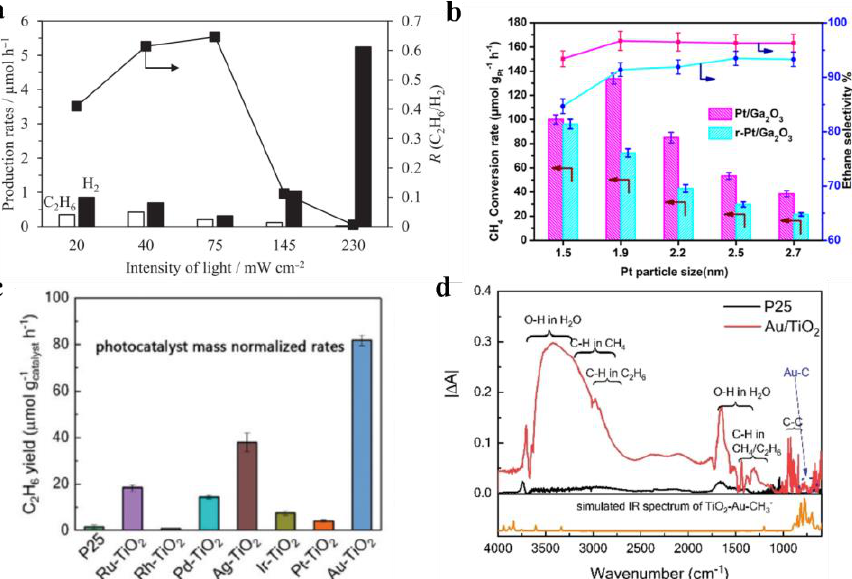
Figure 5. ( a ) Production rates on Pd/Ga 2 O 3 with different light intensities [32], copyright 2011, Else- vier. ( b ) Photocatalytic reaction conversion and selectivity of Pt/Ga 2 O 3 [46], copyright 2021, Ameri- can Chemical Society. ( c ) C 2 H 6 yield over TiO 2 catalysts supported by different noble metals in